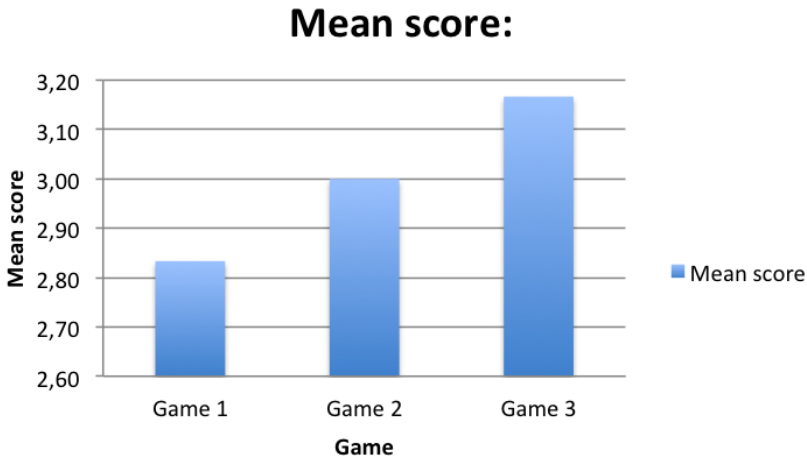
Figure 8. Graph representing the mean score obtained in each game.